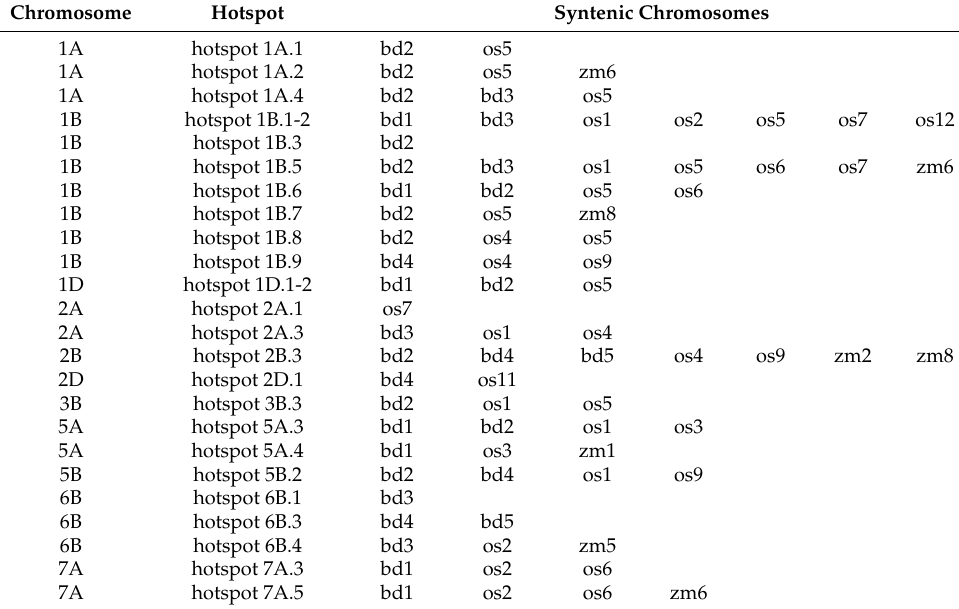
Table 5. Summary of QTL hotspots in syntenic